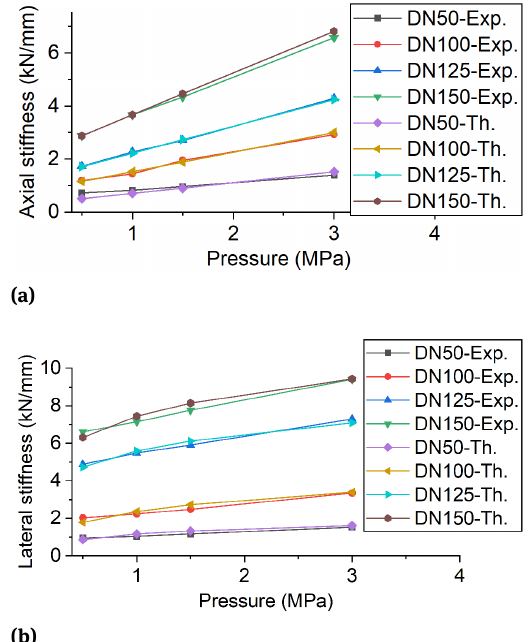
Figure 13: (a) Calculated and measured axial stiffness vs internal pressure; (b) calculated and measured lateral stiffness vs internal